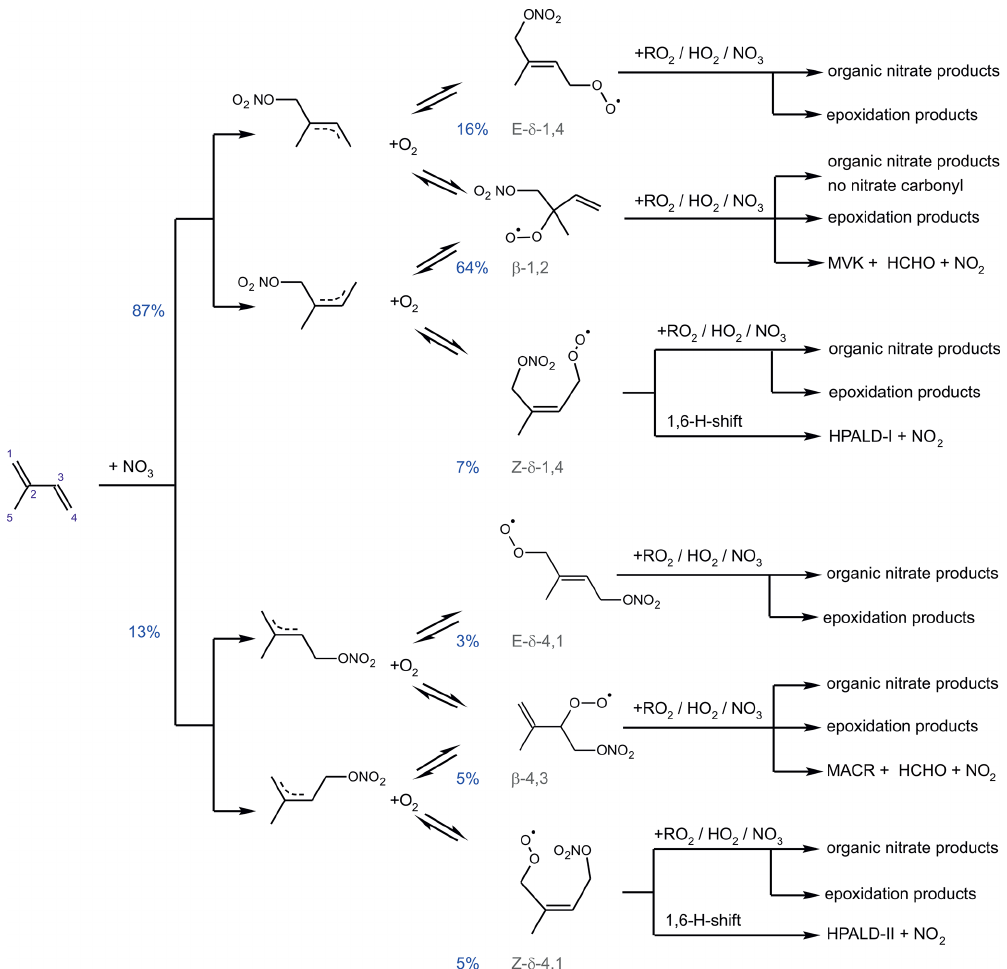
Figure 3. Schematic reaction mechanism of the reaction of isoprene with NO 3 as described in Vereecken et al. (2021). This includes fast interconversion of nitrate RO 2 isomers by oxygen addition and elimination reactions. Only RO 2 isomerization reactions (Vereecken et al., 2021) which can compete with bimolecular reactions for typical night-time conditions are shown. Percentage values given next to the structure of RO 2 radicals are yields when equilibrium concentrations are established for typical night-time conditions such as in the experiments in this work. HPALD: hydroperoxy aldehyde; MVK: methyl vinyl ketone; MACR: